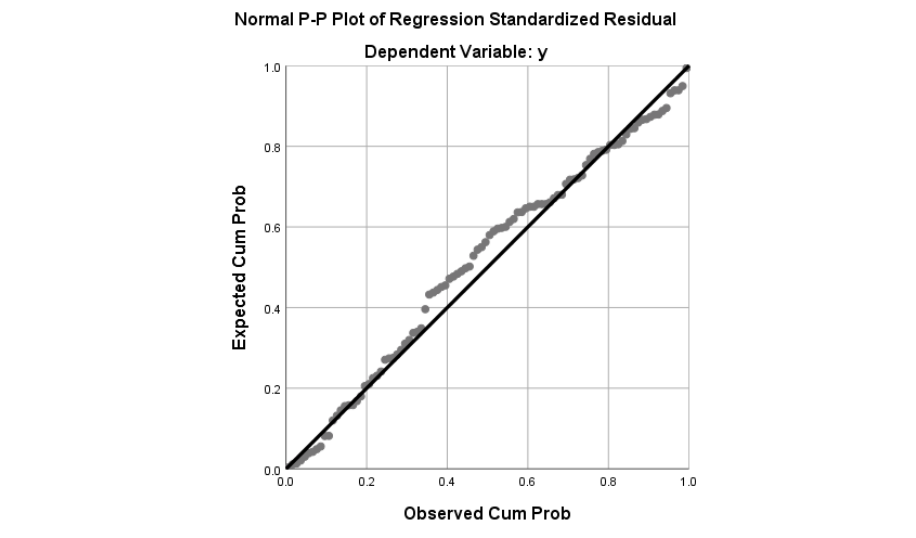
Figure 3 Detection of Normality Normal Probability